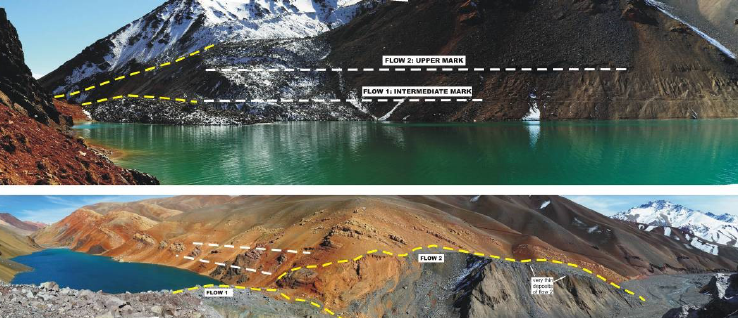
Figure 4. Two ground-acquired photomosaics showing the dissected dam and the interpreted flows from different perspectives. Viewpoints are indicated as 4U for the upper photomosaic and 4L for the lower one in Figure 1. Both mosaics show the two most important water level marks (white dashed lines) and the top of the two different flow deposits (yellow dashed lines). Upper mosaic: Shows the match between major lake-level water marks and the two deposits recognized in the field survey. Compare this mosaic with Figure 2. Lower mosaic: Taken from the avalanche couloir to the distal end of the flows. Arrows point to the opposite wall of the pre-existing canyon wall, reworked by the 2005 flood. Erosive cut shows older mass-wasting deposits, covered by local derived talus sediments (reddish) and only very thin remains of the Flow 2 deposit at the canyon wall shoulder (arrows).